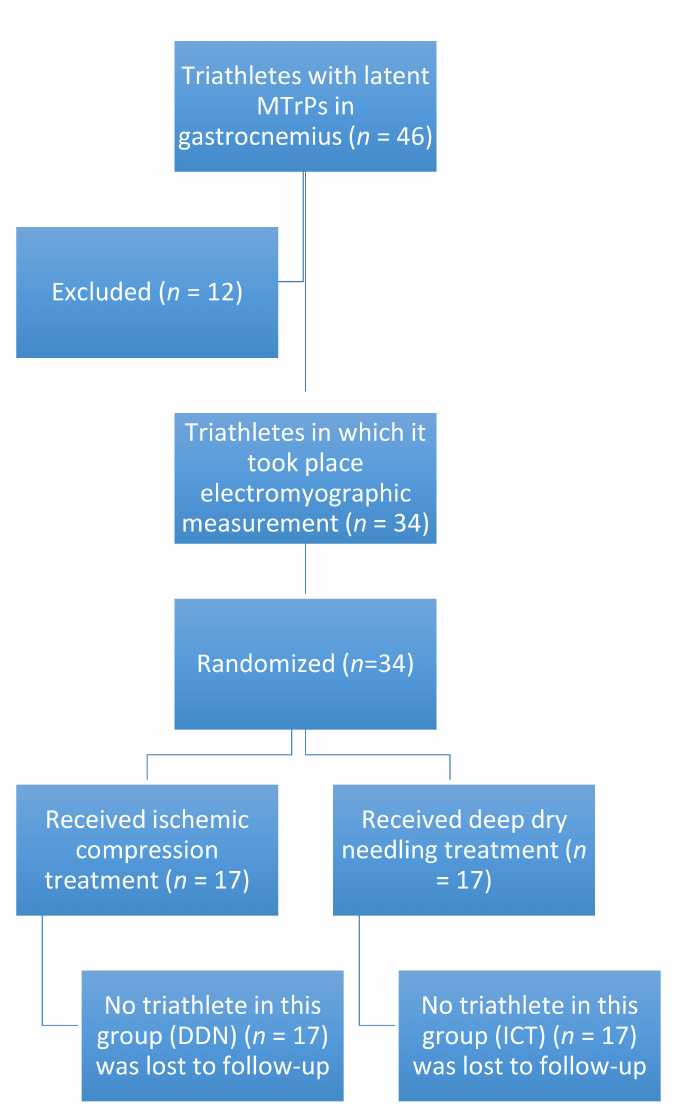
Figure 1. Flow diagram of patients throughout the course of the study.